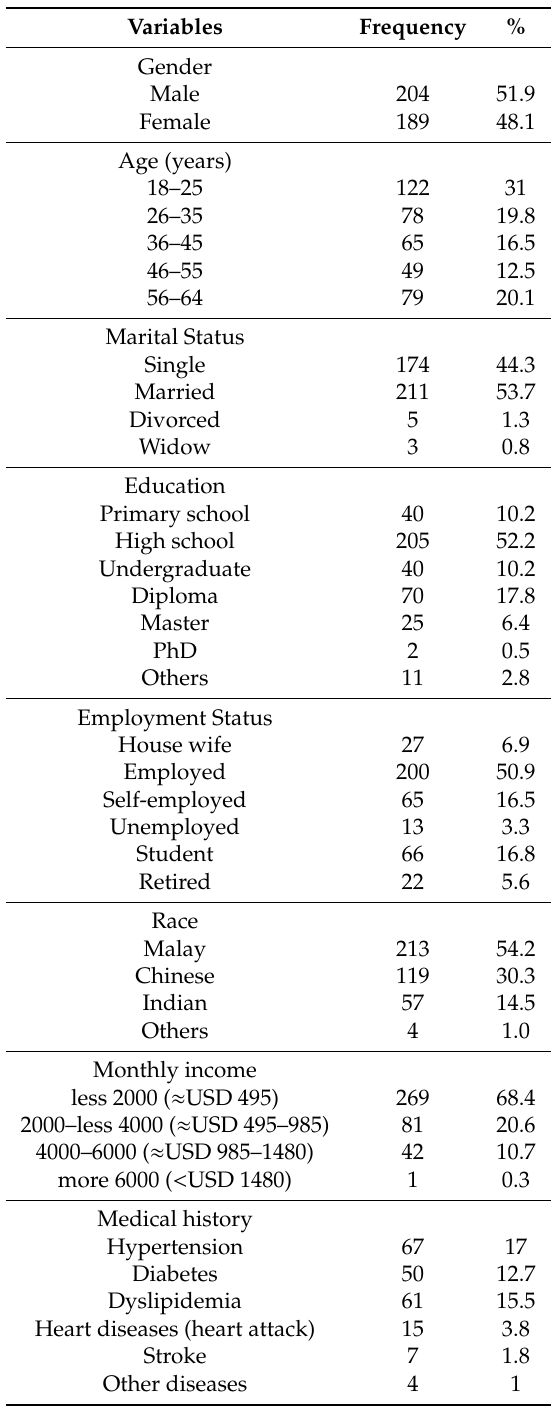
Table 1. Demographic characteristics of